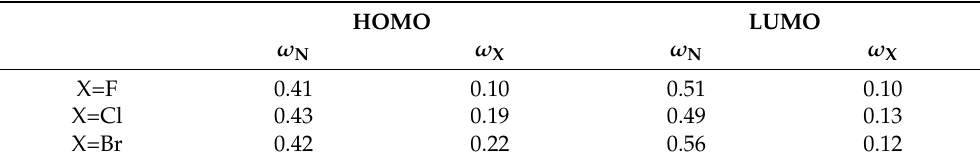
Table 2. Approximate weights of the AOs located on the N and X (X=F, Cl and Br) atoms of the solute in the MOs involved in the excitation to S 1 , which in all cases are the HOMO (as origin of the excitation) and LUMO (as its destination). The ω values given correspond to the vertical excitations computed at the gas phase minimum energy structure in the ground electronic state using Equation (3). HOMO LUMO ω N ω X ω